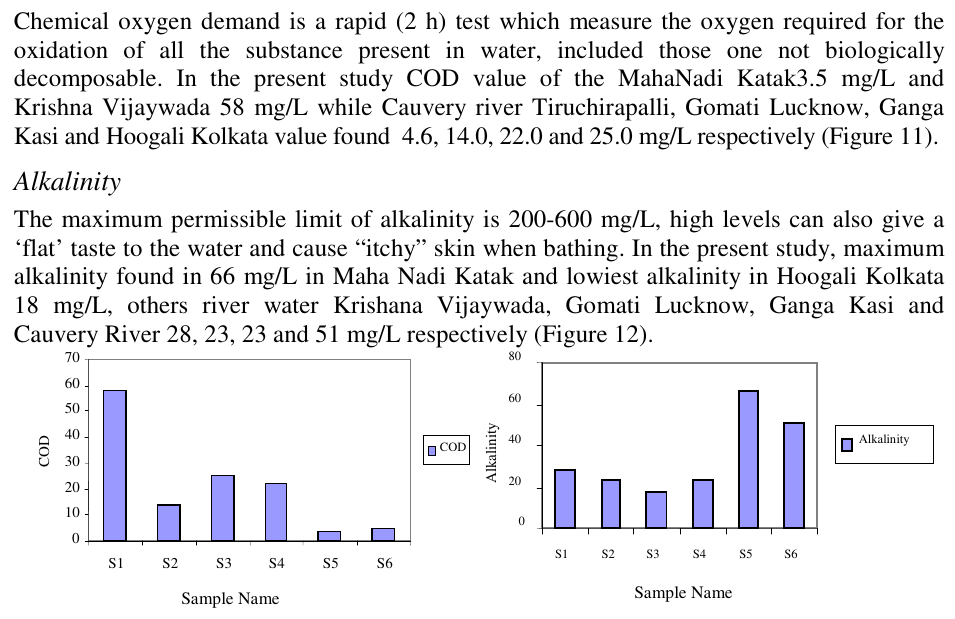
Figure 11 . COD in various sample Figure 12. Alkalinity value of various sample